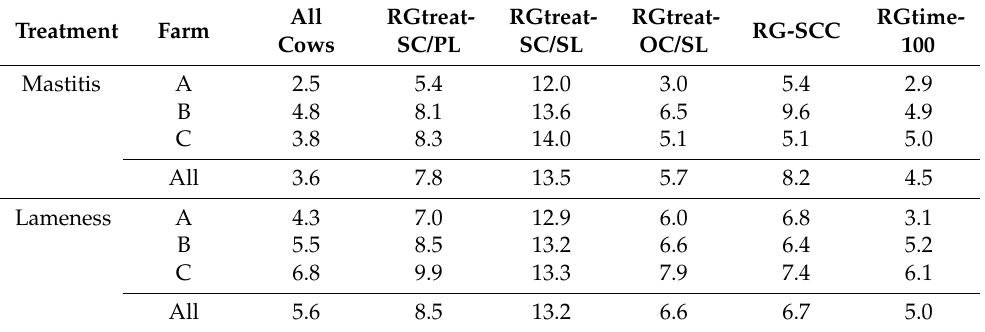
Table 4. Frequency (%) of cow-days with a mastitis treatment and lameness treatment in the testing data for all cows (no specific risk